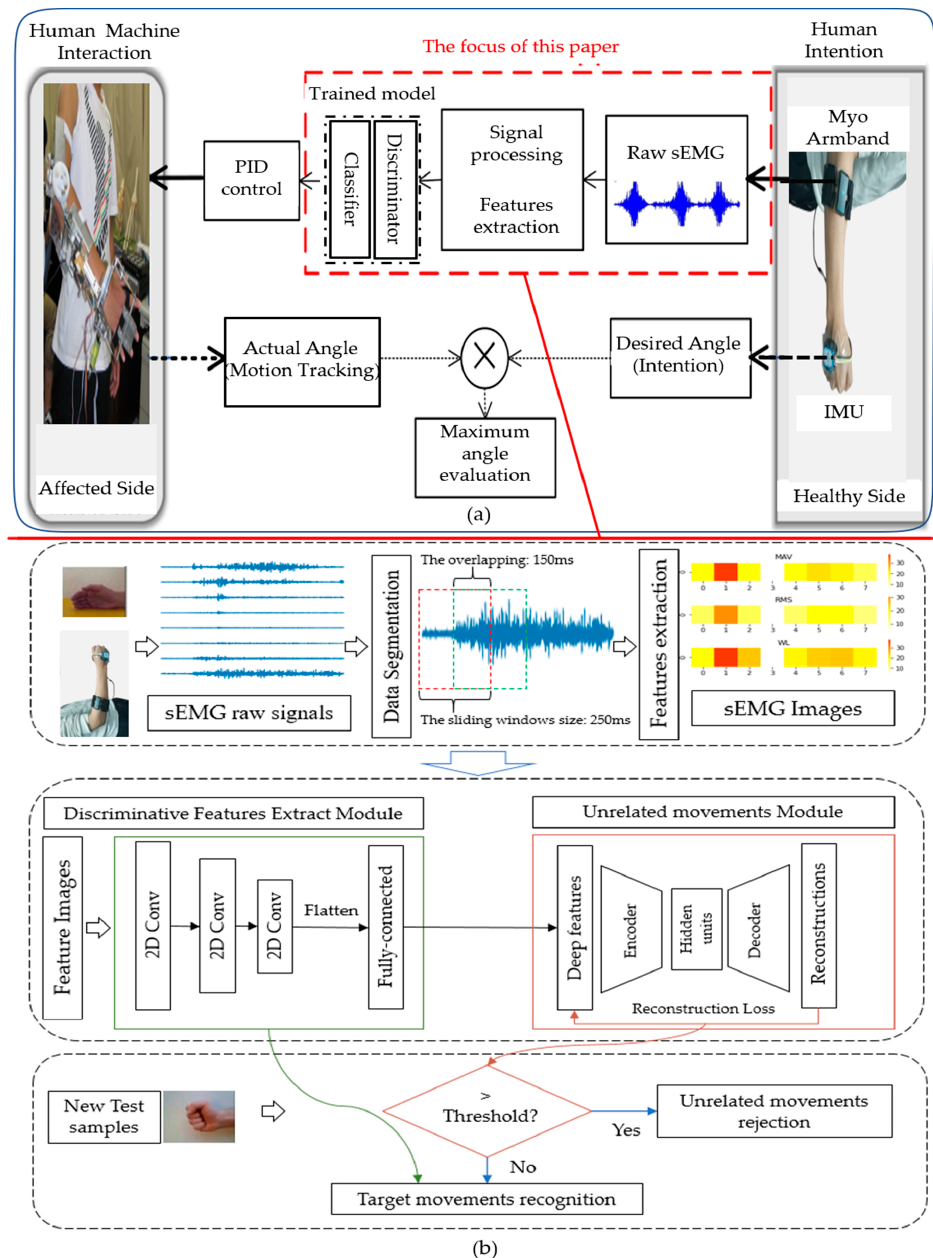
Figure 1. The overview of the system: ( a ) Bilateral rehabilitation based on joint pattern recognition from sEMG signals [4]; ( b ) The overview of the proposed method in this paper.